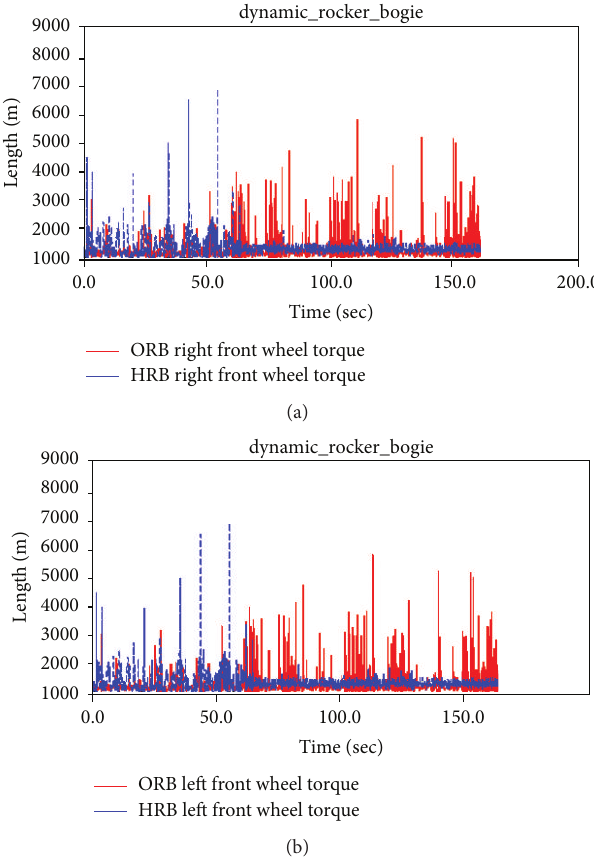
Figure11:Torquevariationofthefrontwheel:(a)torquevariationof the right front wheel and (b) torque variation of the left front